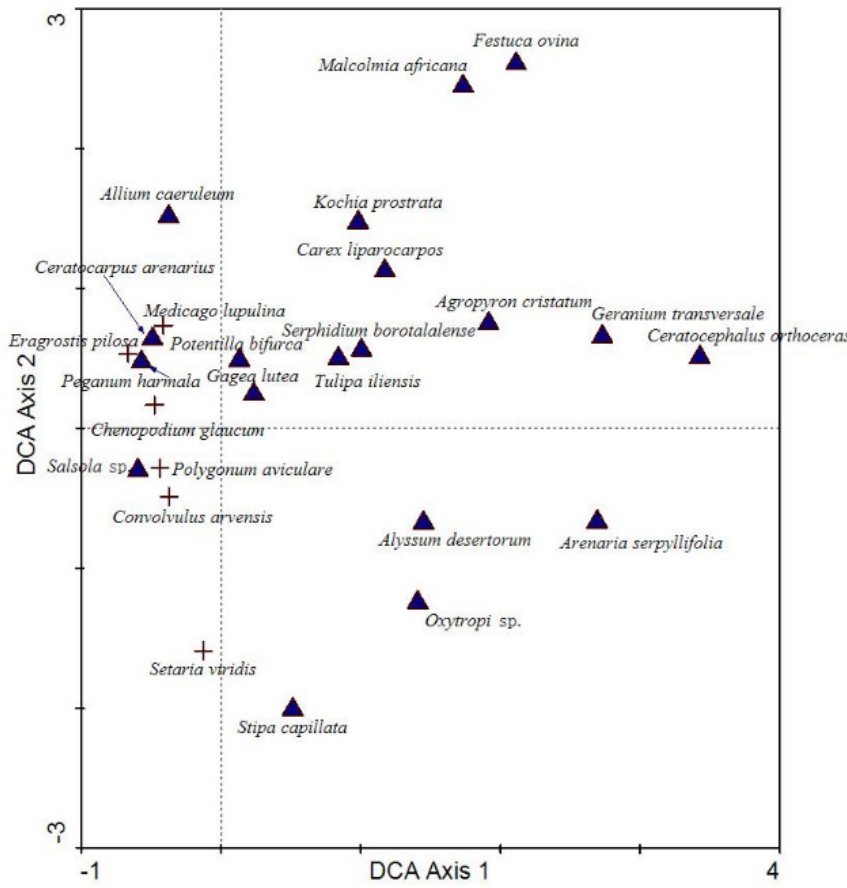
Figure 4. DCA ordination of 25 species (“ ▲ ” = local species, “+” = exotic species). Table 2. Comparison of species diversity characteristics of four